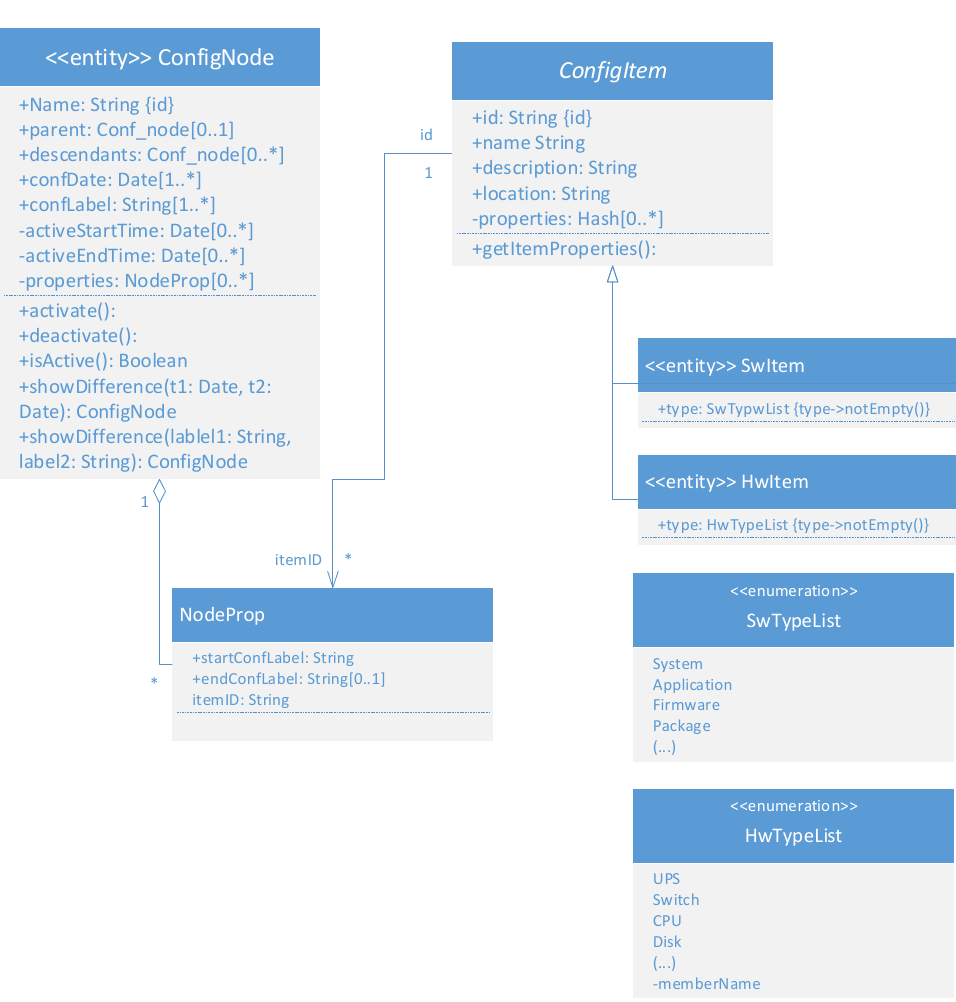
Figure 8. Example of UML representation of configuration node for a digital twin.